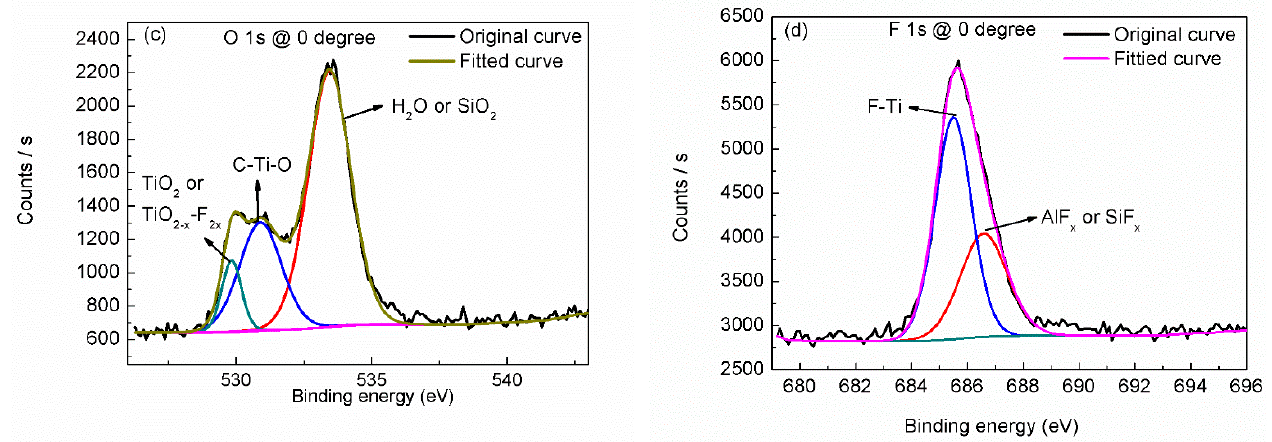
Figure 3a,c,e show angle-resolved narrow scanning curves of C 1s, Ti 2p and O 1s. Figure 2. Peak fitting of narrow scanning, ( a ) C1s, ( b ) Ti 2p, ( c ) O 1s and ( d ) F 1s. Table 1. Peak-fitting results of C 1s, Ti 2p, O 1s and F 1s narrow scanning’s. Further, ratio depth (within 10 nm) profile of different bonds were obtained from analyzing the angle-resoled narrow scanning curves, as shown in Figure 3b,d,f. According to the ratio depth profile of C–Ti bond (as shown in Figure 3b), the Ti 3 C 2 T x MXene should locate in the subsurface, under the adsorption layer. Ratio depth profiles of different Ti bonds (as shown in Figure 3d) indicate that there may be more than one layer of Ti 3 C 2 , and O/F atoms may exist between the Ti 3 C 2 layers. Ratio depth profiles of different O bonds (as shown in Figure 3f) approve that O atoms exist not only on the top surface but also with the Ti 3 C 2 layer. Comparing the ratio depth profiles of C–Ti–C bond and O–Ti–C bond, it is found that there is a staggered distribution between the two bonds, being consistent with the inference that O atoms exist between Ti 3 C 2 layers acting as surface group. With increasing detection depth, the content of O bonds at 533.4 eV decreases first and increases then. Since the peak at 533.4 eV could be ascribed to either H 2 O or SiO 2 , it is deduced that the peak at 533.4 eV should arise from adsorbed water near top surface and arise from oxide on substrate under the top surface. Therefore, the large amount of adsorbed water near the top surface layer indicates that there could be OH − on the surface of Ti 3 C 2 layer acting as surface functional group.